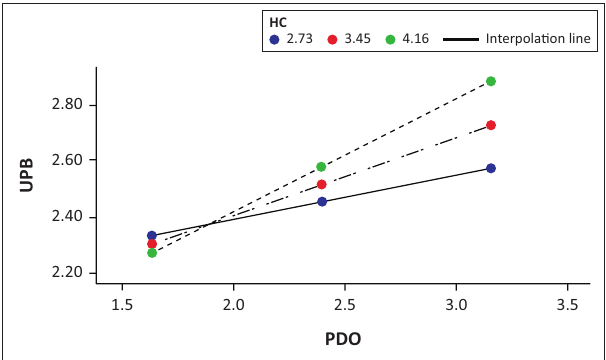
FIGURE 3: Regression results for moderation effect on the relationship between power distance orientation and unethical pro-organisational